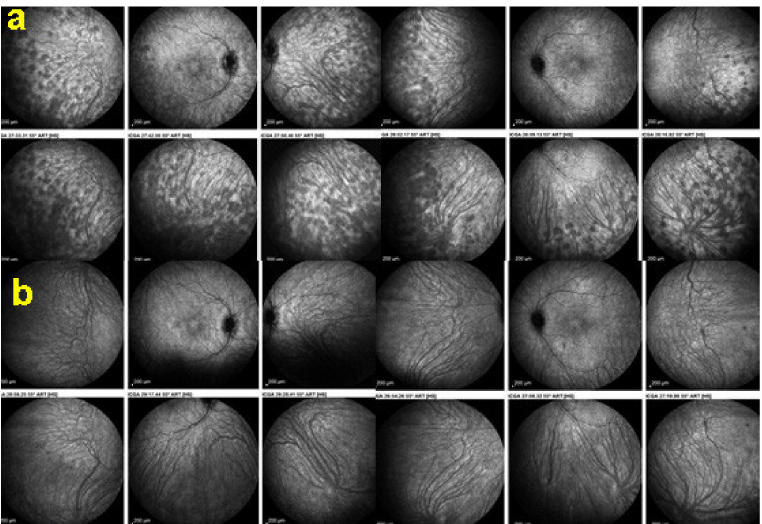
Figure 49. ICGA in VKH disease. Regular distribution all over the fundus of evenly sized HDDs before treatment ( a ) having mostly disappeared after the introduction of dual steroidal and non- steroidal immunosuppression ( b ).